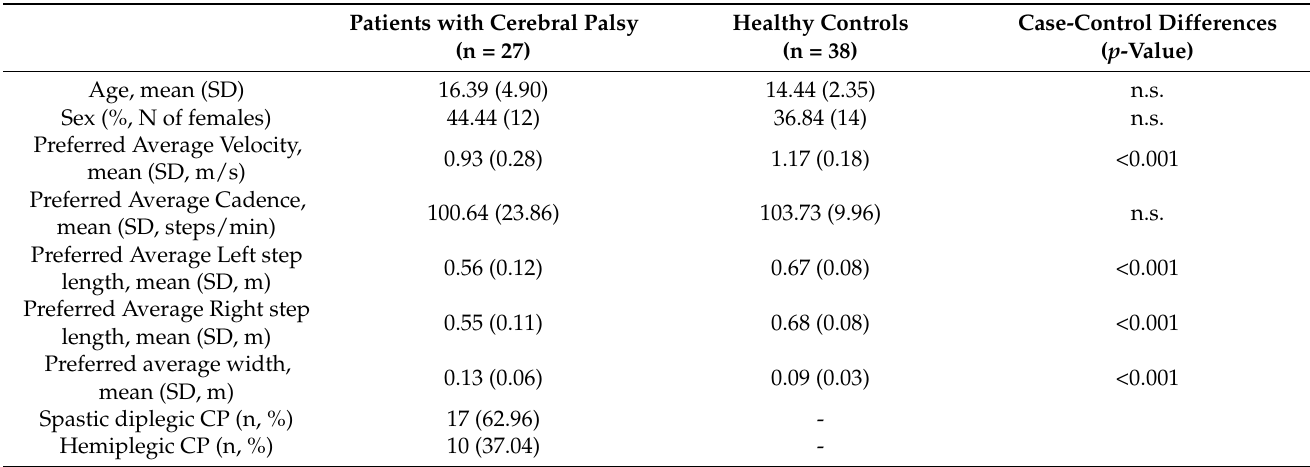
Table 1. Demographic